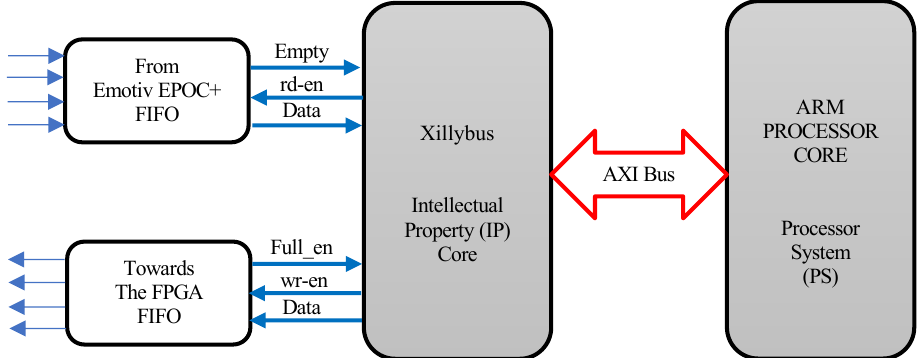
Figure 3. The Xillybus IPs Core was used as a data transport mechanism and configured to interconnect the processor core with the FPGA. The primary control signals include the write enable (wr-en), read enable (rd-en), and FIFO full enable (Full-en). Adapted from Xillibus Ltd. Emotiv EPOC+ data writing (rd-en) is enabled as First-In, First-Out (FIFO) when it